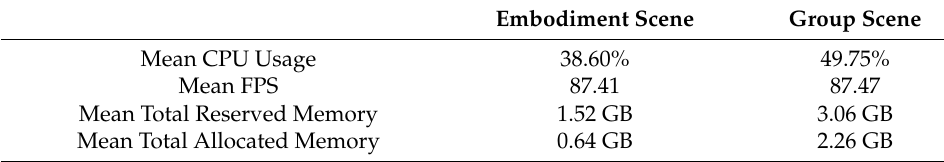
Table A4. Mean results for Test Condition